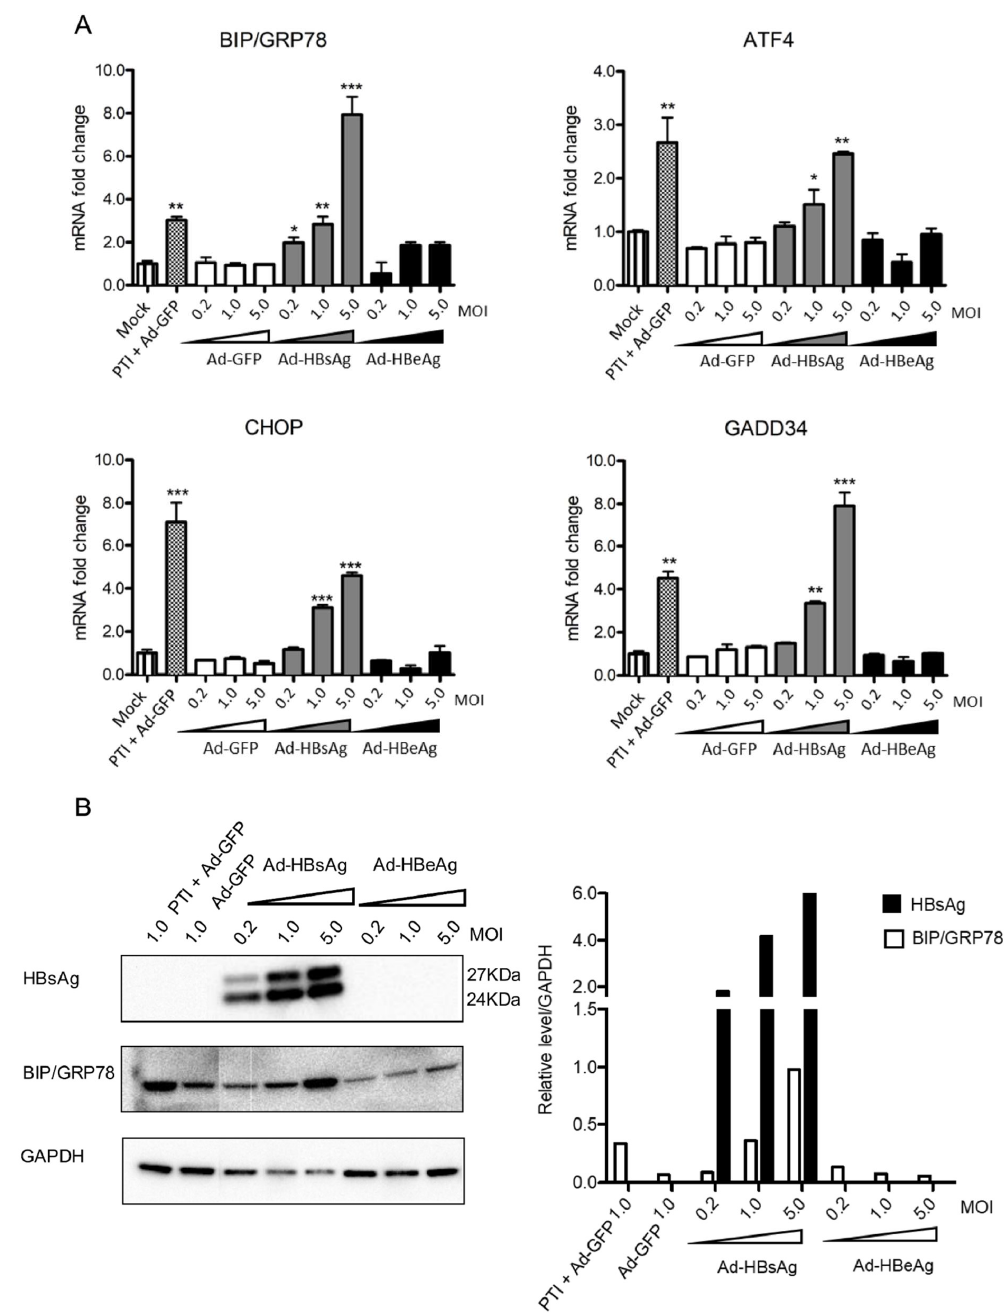
Figure2. Dose-dependentinductionofPERKpathwaygenesbyHBsAgexpression. Ad-GFP,Ad-HBsAg and Ad-HBeAg were transduced into HepG2-NTCP cells with increasing MOIs of 0.2, 1.0 and 5.0 in triplicate. Protein transportation inhibitor (PTI) was used as a positive control. ( A ) Three days after transduction, mRNAs of BIP / GRP78, ATF4, CHOP and GADD34 were determined by RT-qPCR. The Student’s unpaired two-tailed t test was applied for data analysis. * p < 0.05, ** p < 0.01, *** p < 0.001. ( B ) Expression of HBsAg and ER stress marker BIP / GRP78 were measured by Western blotting (left panel) and signals quantified (right panel). All results were confirmed by three independent